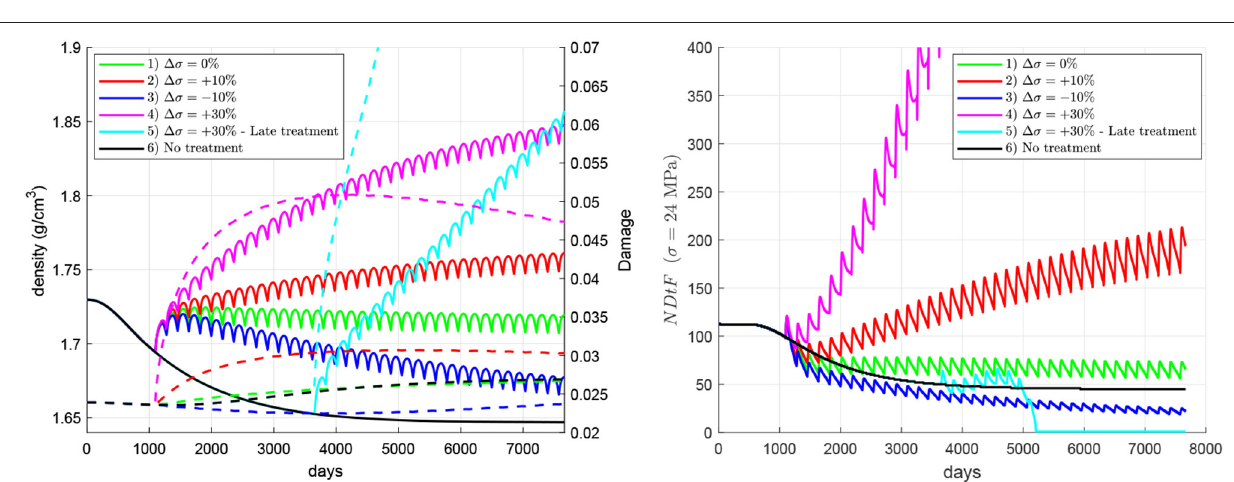
FIGURE 7 | Influence of an increment in the applied stress coinciding with the beginning of the treatment. Evolution of density (left, solid lines), damage (left, dashed lines), and NDtF- σ = 24 MPa (right) for treatment 60Q6. Four cases of changes in the applied stress are compared with the nominal case (no change) and the non-treatment